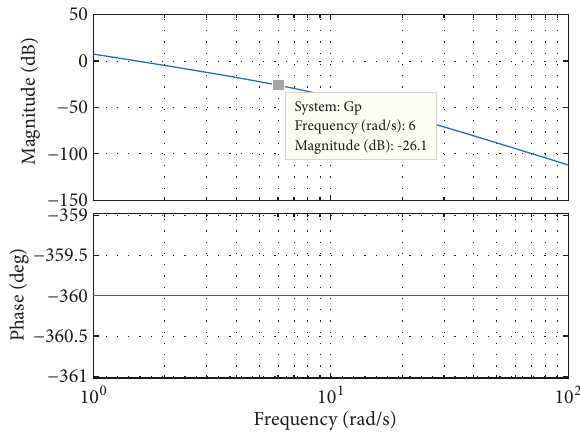
Figure 7: Bode diagrams of 𝐺 1 (𝑠)